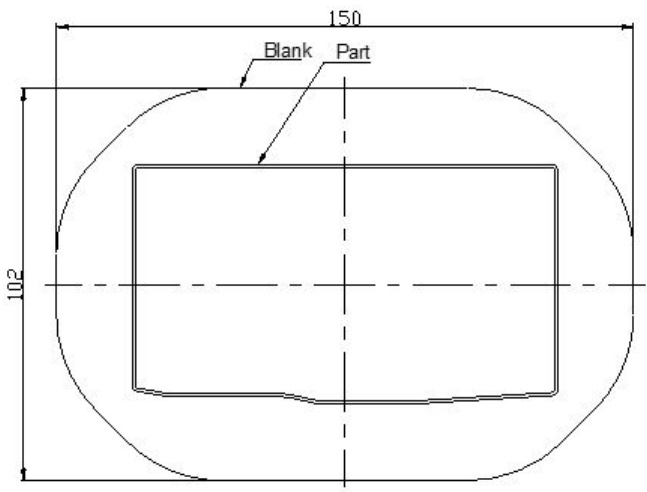
Figure 4. The shape of sheet blank (unit: